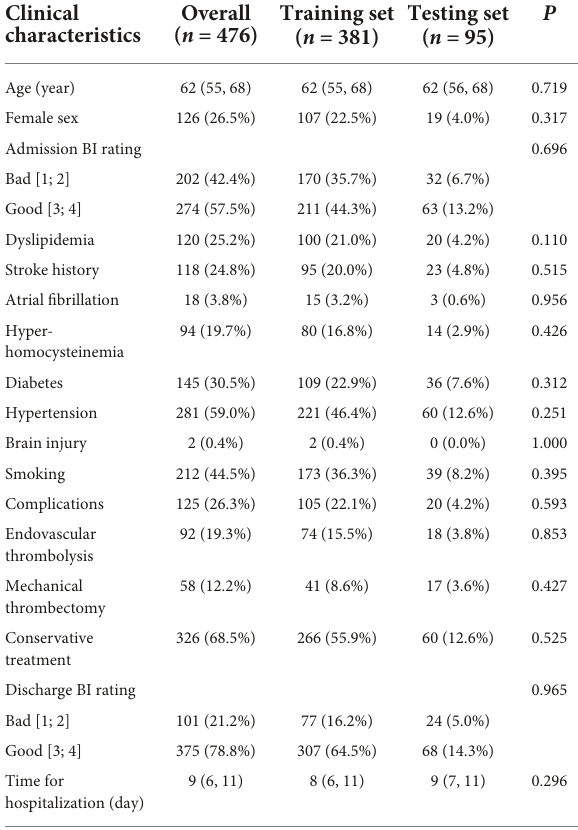
TABLE 1 Baseline characteristics in study sample ( n =